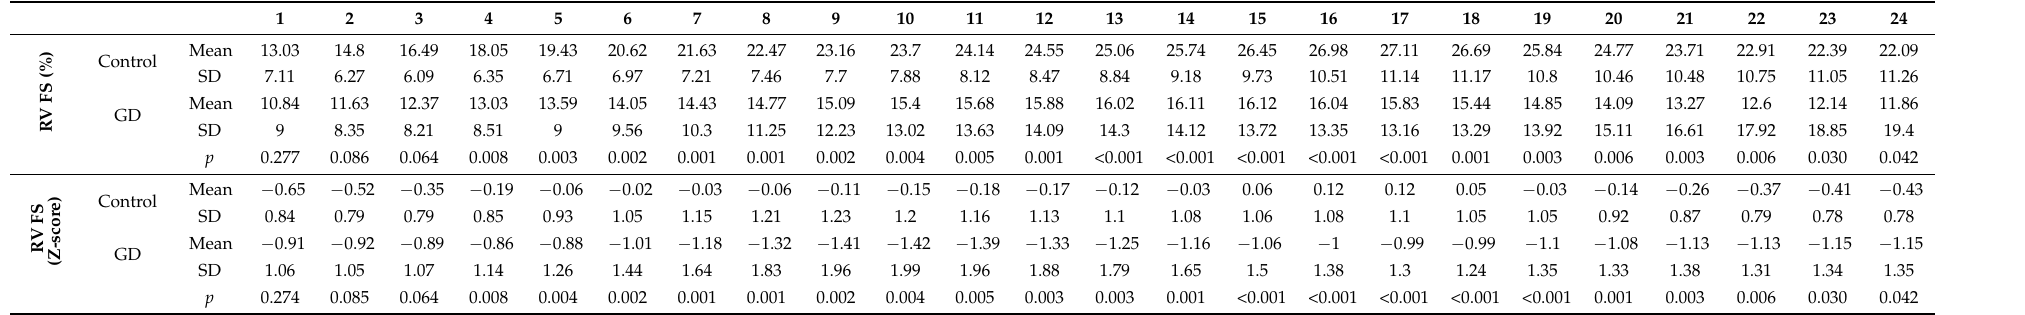
Table 2. Comparison of the right ventricular 24-segment fractional shortening between the Control group and the GD group.